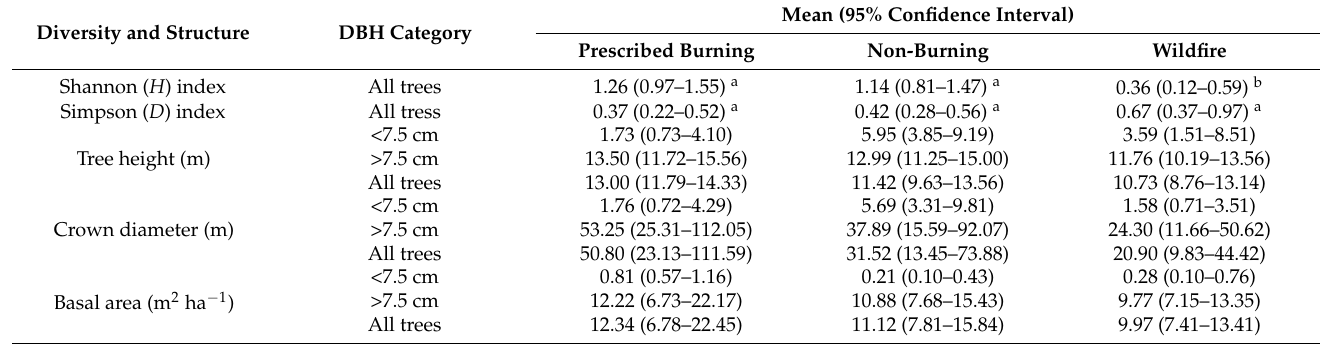
Table 1. Tree diversity indices and forest structural parameter differences between prescribed burning, non-burning, and wildfire sites of tropical highland forests in Chiapas, Mexico. Different superscript letters followed by mean values denote significant differences between burning treatments (Tukey HSD p < 0.05).